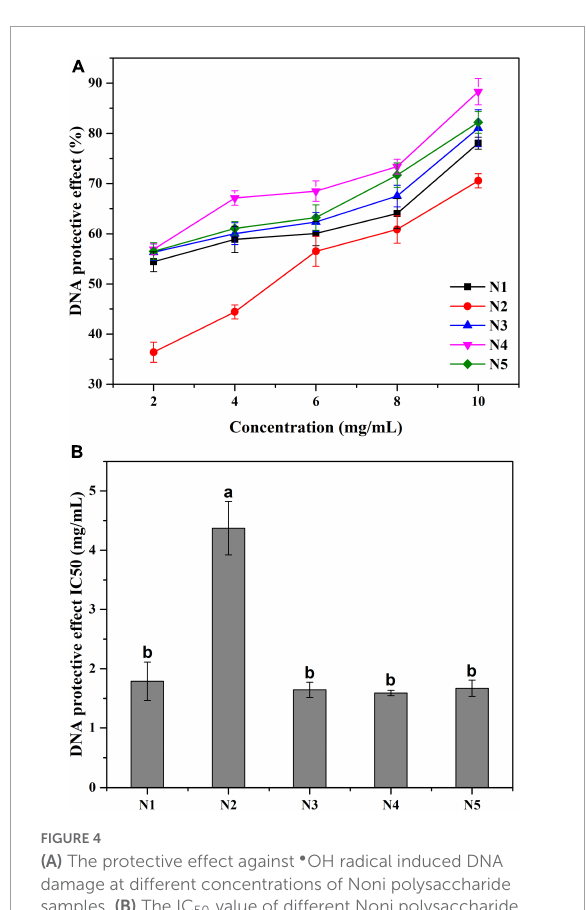
FIGURE4 (A) The protective effect against • OH radical induced DNA damage at different concentrations of Noni polysaccharide samples. (B) The IC 50 value of different Noni polysaccharide samples. Data marked with different letters are significantly different at p < 0.05.